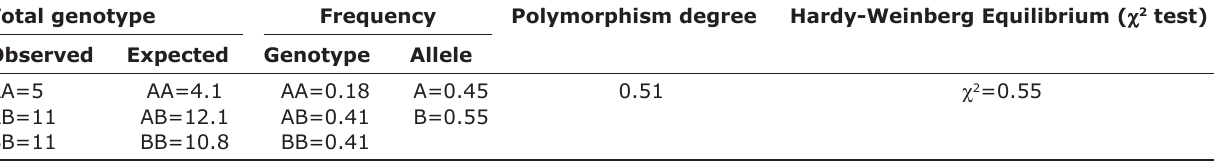
Figure-2: Results of agarose gel electrophoresis of FABP4 restriction fragment length polymorphism fragment (200 bp). Lane M, 100 bp ladder. Lane 01-15, Aceh cattle examined. Table-4: MSTN allele and genotype frequencies and polymorphism in Aceh cattle*.